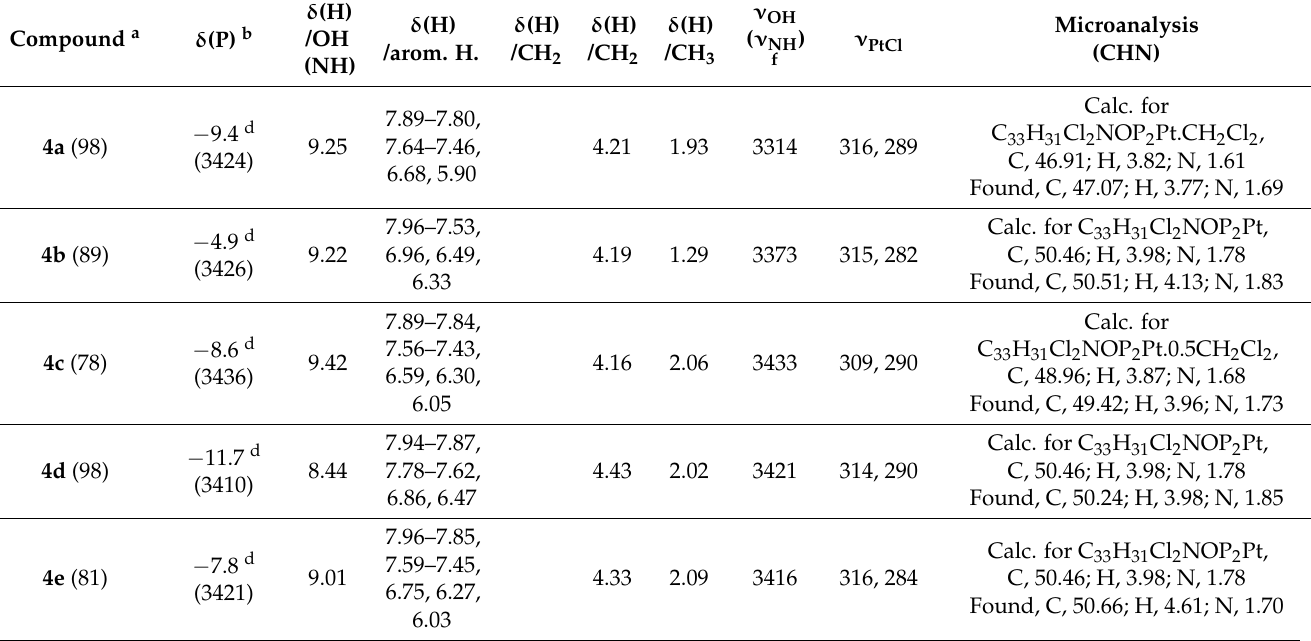
Table 4. Selected spectroscopic and analytical data for compounds 4a – 6 a .